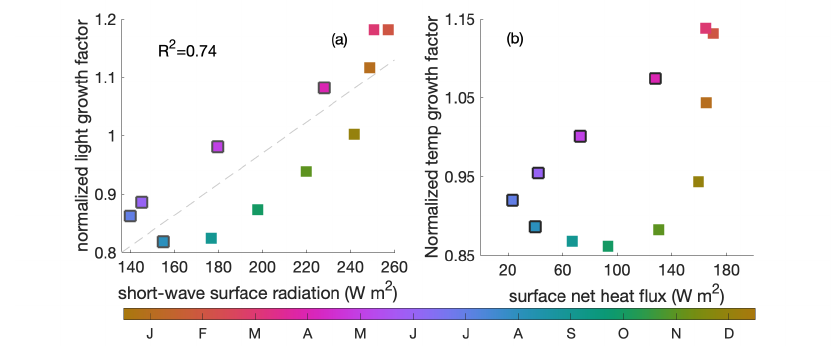
Figure C2. (a) Correlation between surface short-wave radiation (Wm − 2 ) and the averaged light-related growth factor within the mixed layer, (b) correlation between the surface heat forcing (in ◦ Cd − 1 ) and averaged temperature-related growth factor within the mixed layer. Colour indicates the time of the year and black edges the decline phase.